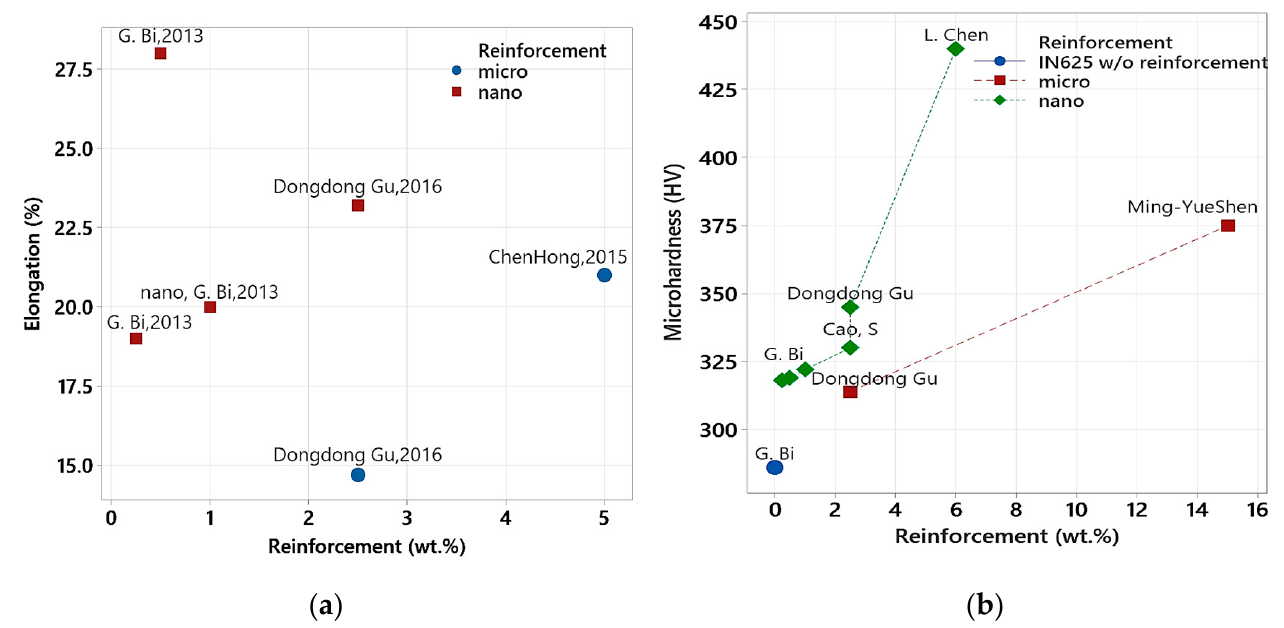
Figure 18. E ff ect of TiC reinforcement concentration and particle size ( a ) on the ductility of the IN625 composite, ( b ) microhardness vs. reinforcement (See Appendix A for data sources).